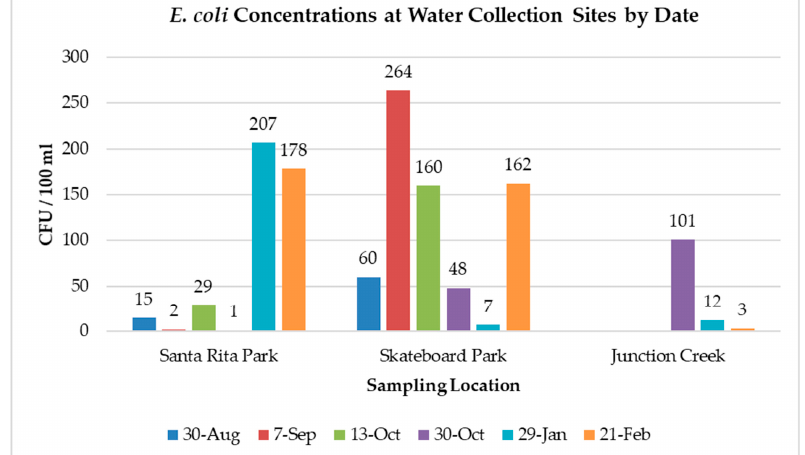
Figure 2. E. coli concentrations for the Animas River watershed, measured August 2014–February 2015. Values given are the means of triplicate counts. After streaking for isolation and performing Gram staining, most students were able to microscopically observe Gram-negative coliform bacteria, consistent with positive isolation of E. coli . Students having mixed cultures of bacteria (mix of Gram-positive and Gram-negative bacteria), or Gram-positive bacteria, and/or non-coliforms were guided in preparing a second round of cultures through repeating the streak-for-isolation procedure as time permitted. Students unable to generate a pure isolate of Gram-negative coliforms were still allowed to carry out PCR testing in order to gain experience with the procedures and the experimental aims. During subsequent testing using PCR protocols, 36 out of 72 students were able to confirm the presence of the uid gene for their isolates, supporting the identification of E. coli (data not shown). All samples, both uid -positive and uid -negative, were then tested for the intimin gene. Six isolates of the 36 that were positive for uid also tested positive for eae . None of the uid -negative isolates tested positive for eae . All but one of the